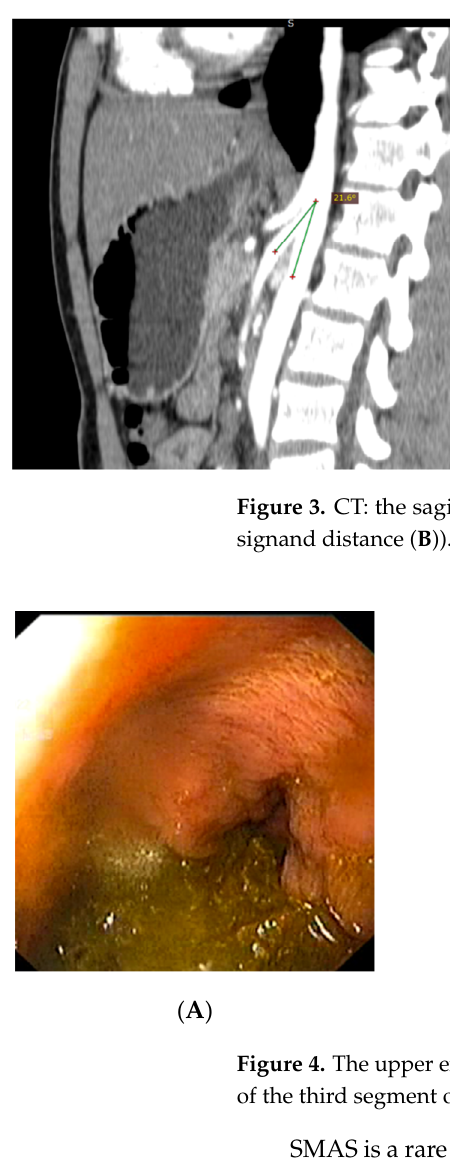
Figure 2. Abdominal ultrasound showing gastric distension.